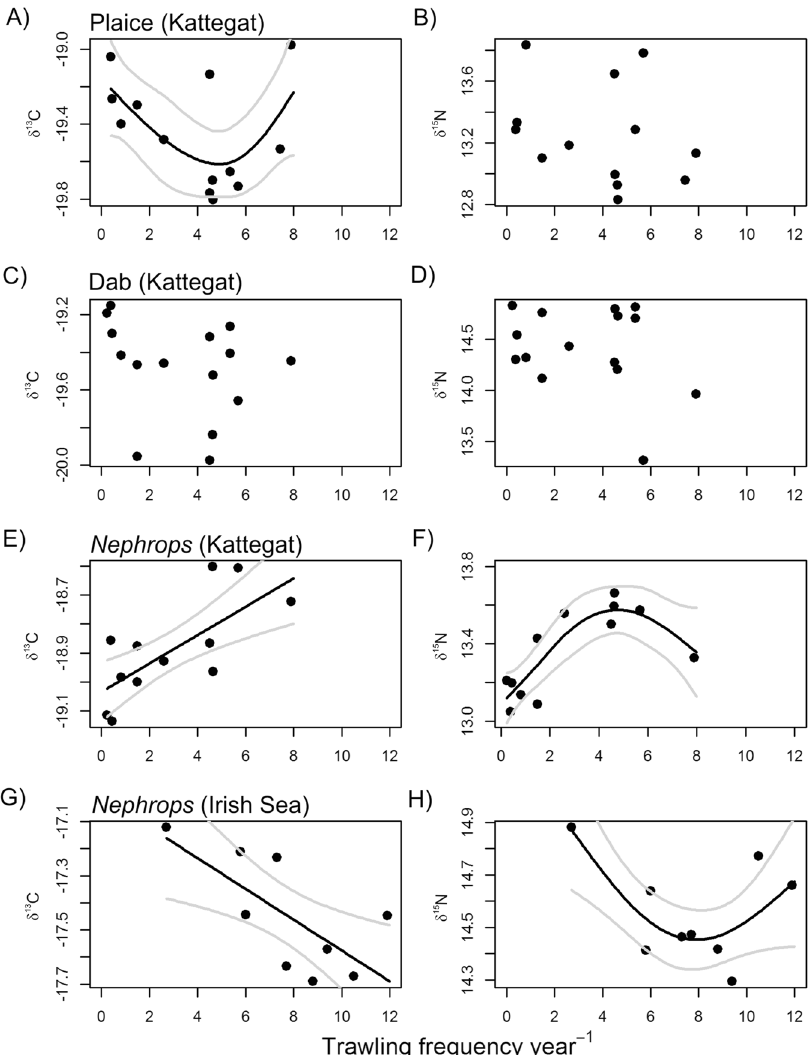
Figure 3. Relationship of isotopic carbon and nitrogen signatures along trawling gradients in muscle tissue of ( A,B ) Plaice in the Kattegat, ( C,D ) Dab in the Kattegat ( E,F ) Nephrops in the Kattegat and ( G,H ) Nephrops in the Irish Sea. Solid black lines signify significant GAMMs and grey lines represent 95% confidence intervals. Points represent mean values at stations.